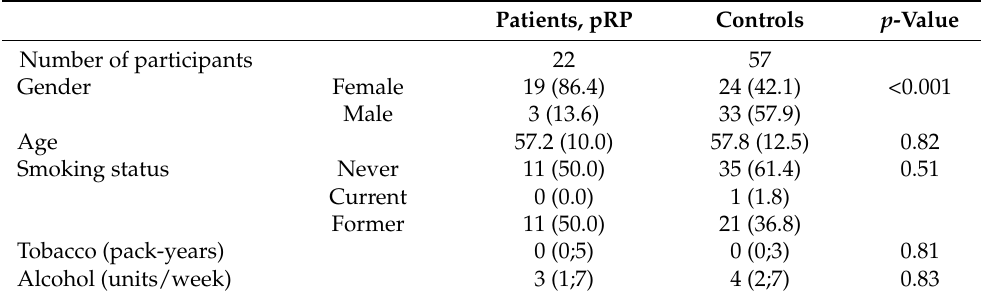
tableone . Trial registration: ClinicalTrials.gov NCT03094910. Table 1. Clinical characteristics of all participants. Data are presented as number (%), mean (SD), or median (IQR). pRP = primary Raynaud’s